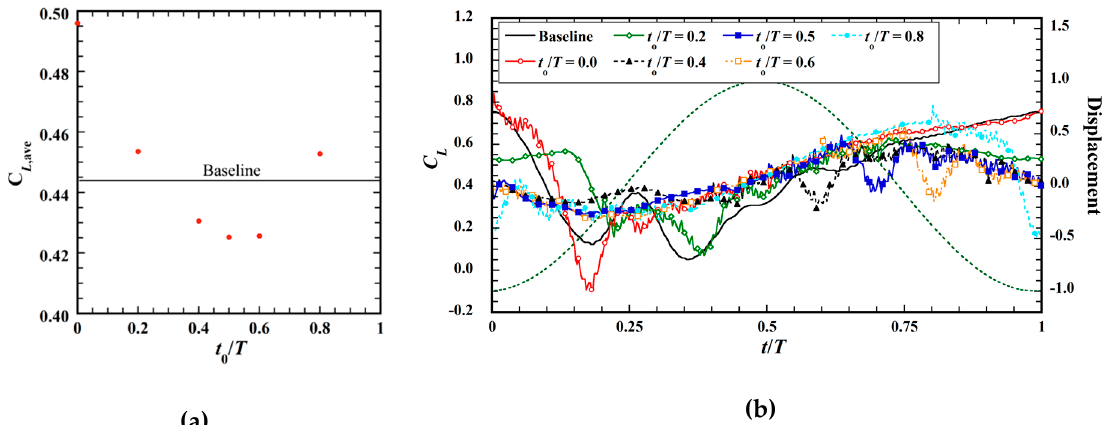
Figure 19. Lift with each time offset for the control only on the top surface ( R = 50%). ( a ) Time-averaged lift coefficient; ( b ) Time fluctuations of lift coefficient.